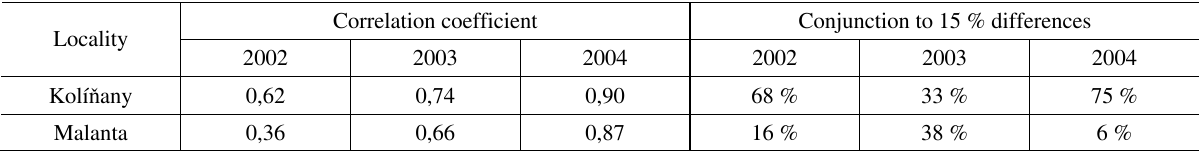
Table 5. Correlation coefficient between simulated and measured values and percentage representation of identical measured and simulated values within difference of 15 % Correlation coefficient Conjunction to 15 % differences